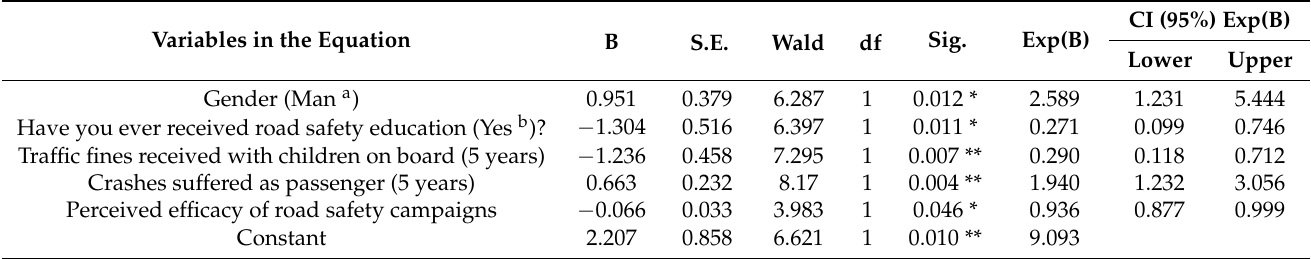
Table 2. Logistic regression model (logit) to explain traffic crashes suffered by parents while driving with children. Variables in the Equation